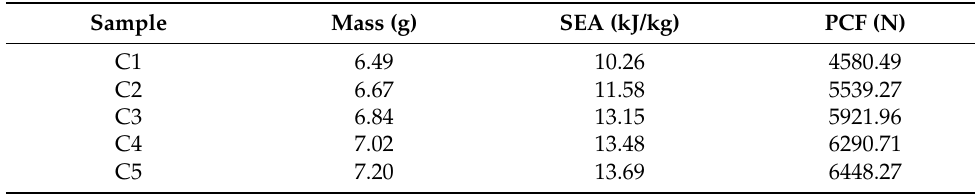
Figure 16. Cellular structures of different sizes b . Table 4. Numerical results of specimens with different sizes of b